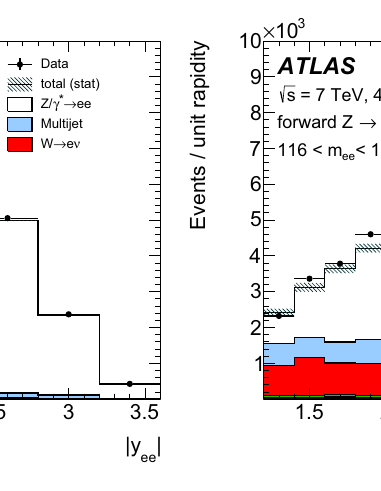
Fig. 9 The dilepton rapidity distributions for Z /γ ∗ → e + e − candi- dates with one central and one forward electron in the mass region 66 < m ee < 116GeV ( left ) and 116GeV < m ee < 150GeV ( right ). Thesimulatedsamplesarenormalizedtothedataluminosity.Themulti- jetbackgroundshapeistakenfromadatacontrolsampleandnormalized Table 1 Number of observed event candidates N , of estimated back- ground events B , and the correction factors C for the W + , W − , central and forward Z /γ ∗ (66 < m ee < 116GeV) electron channels. The cor- rection factors C were defined in Eq. (6). The charge asymmetry in the